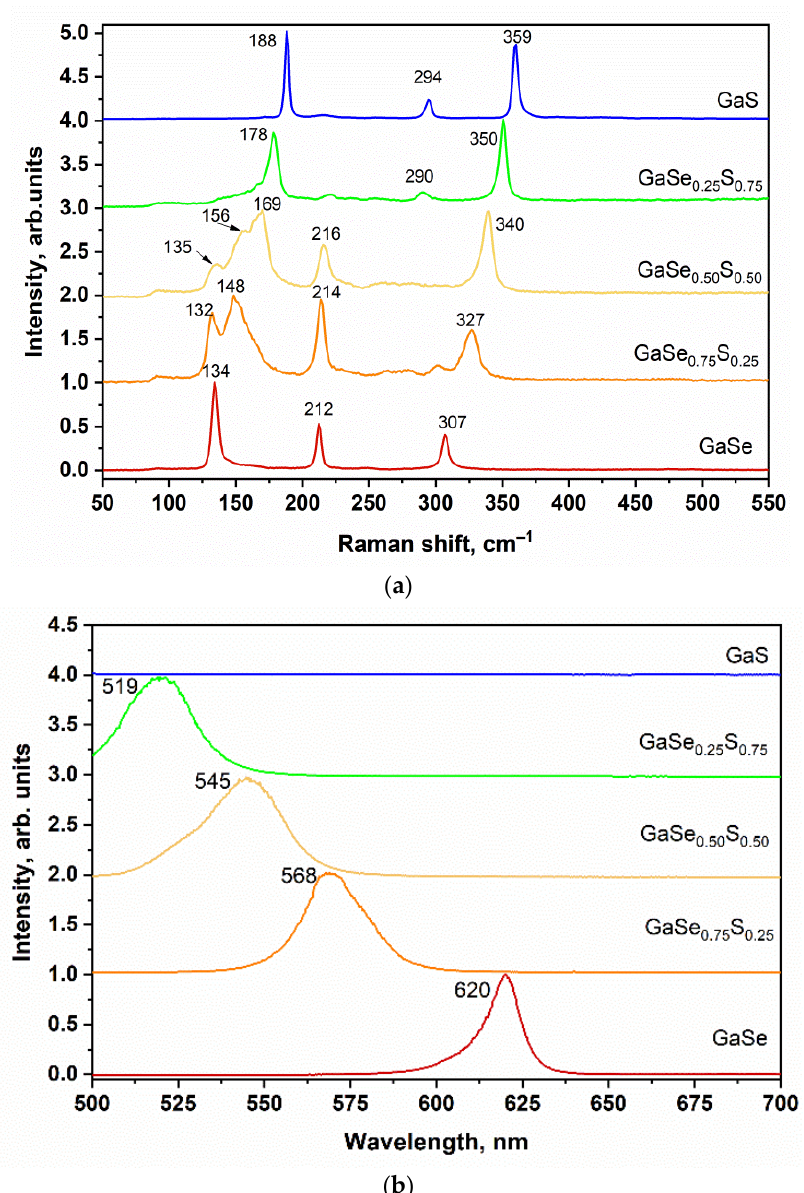
Figure 3. Raman ( a ) and PL ( b ) spectra of the as-grown GaSe 1 − x S x